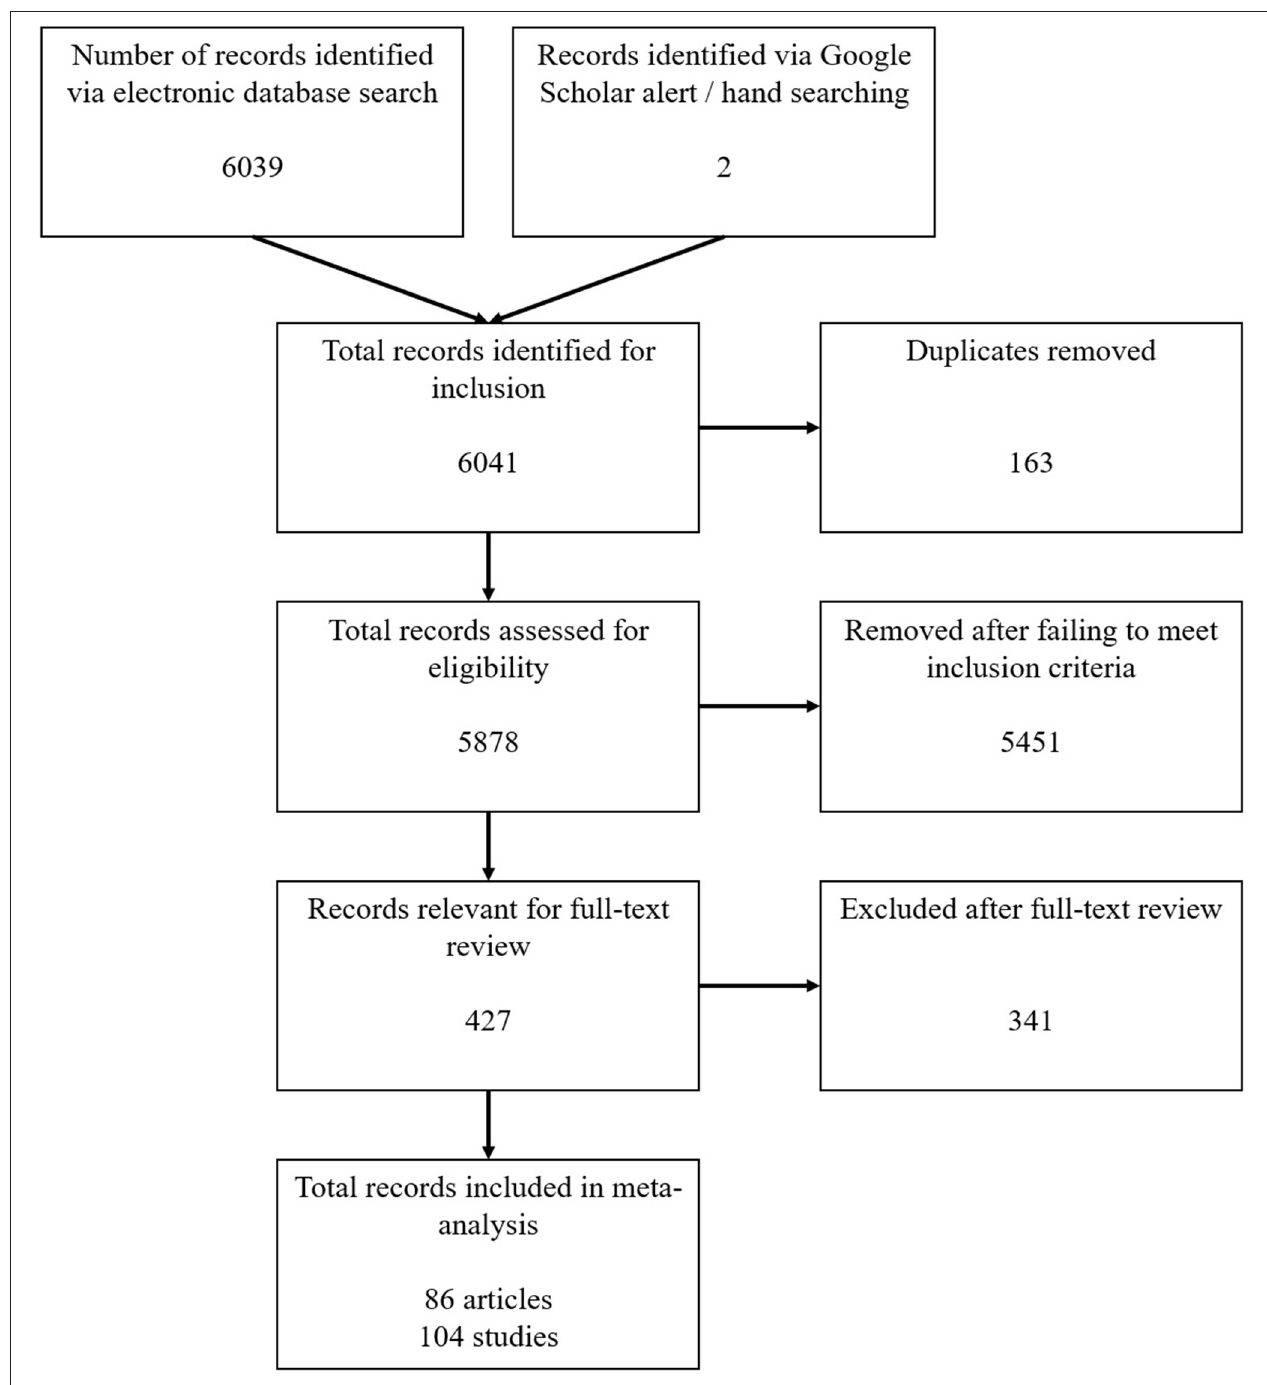
FIGURE 1 | Flow-chart for inclusion and exclusion of articles in the meta-analysis.